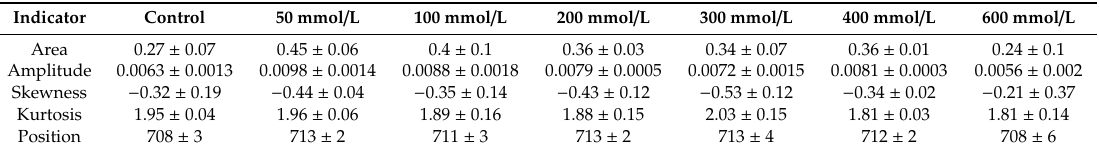
Table 4. Five red edged parameters under di ff erent salt treatments with means ± standard errors (n =